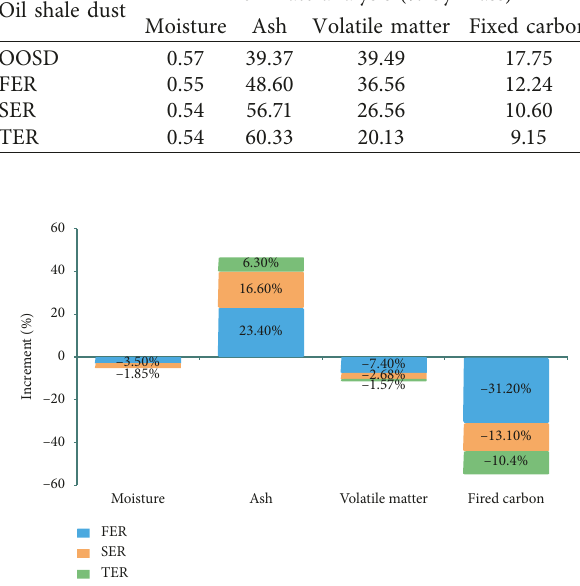
Figure 5: A comparison of the industrial analysis results of the explosive residues of oil shale dust after multiple explosions.